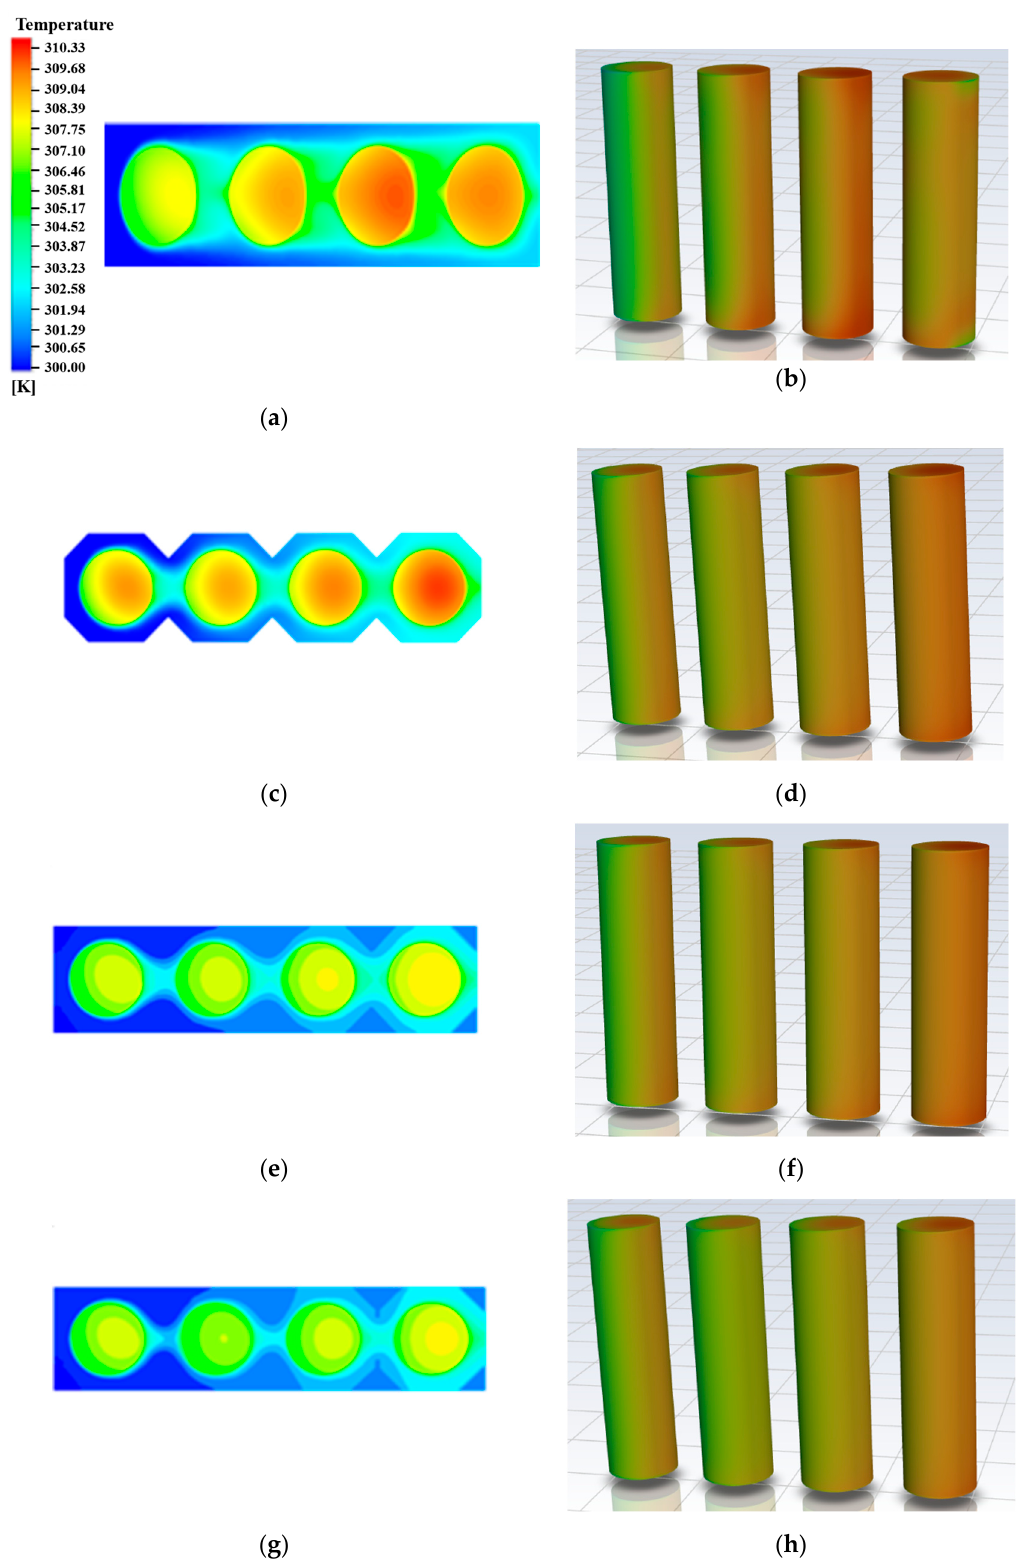
Figure 7. Temperature distribution in the middle section of different schemes and their battery surface temperature graph. ( a ) Scheme A; ( b ) the surface temperature of the battery for scheme A; ( c ) scheme B; ( d ) the surface temperature of the battery for scheme B; ( e ) scheme C; ( f ) the surface temperature of the battery for scheme C; ( g ) scheme D; ( h ) the surface temperature of the battery for scheme D.